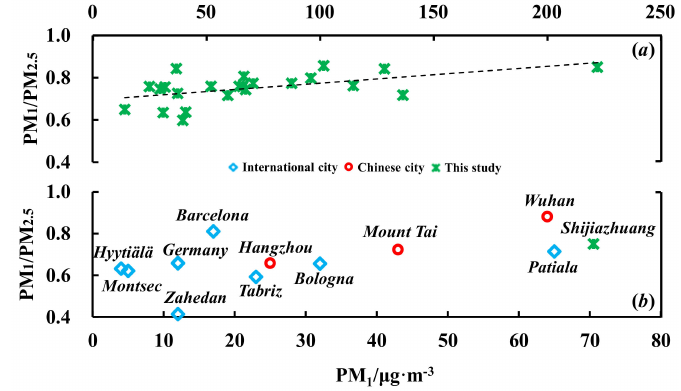
Figure 2. Time series of daily PM concentration and PM 1 /PM 2.5 ratio during the study period.